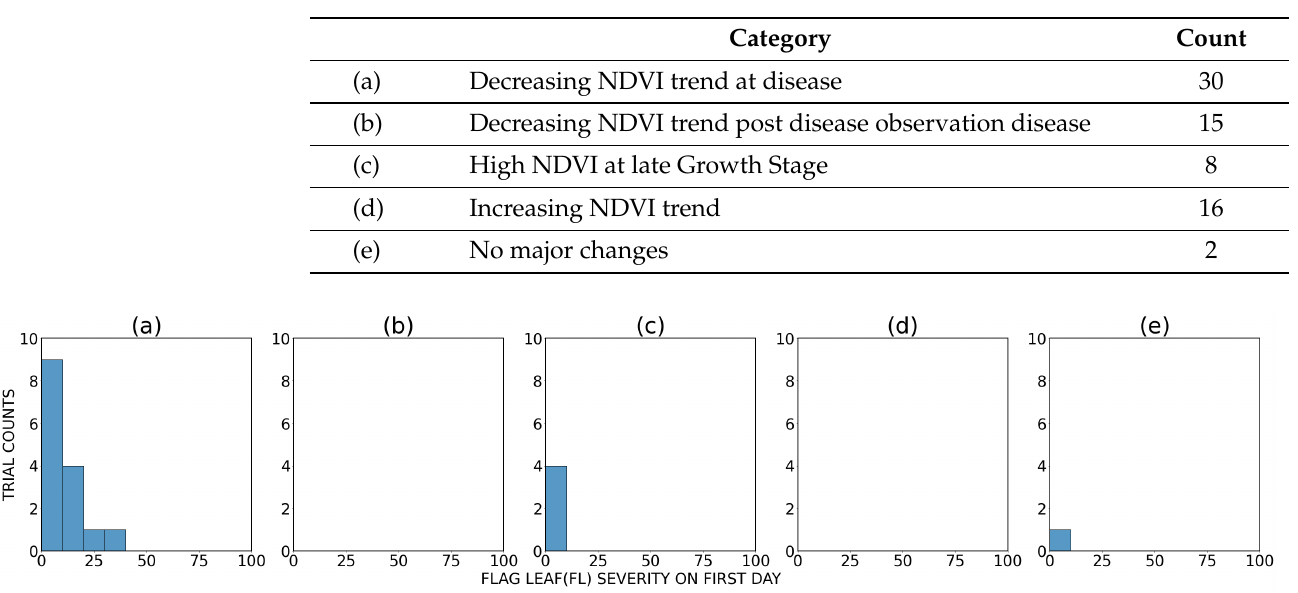
Table 5. Trial categorization after manual observation of NDVI trend around the disease observation.